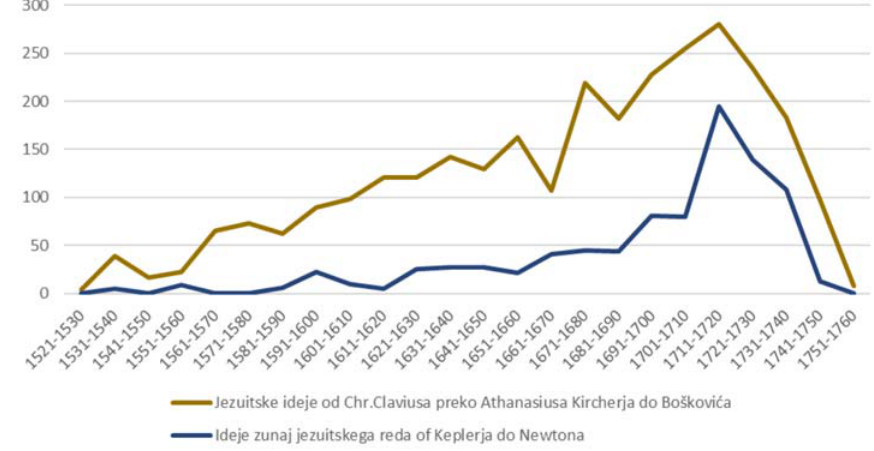
Graf 3: Spreminjanje fizikalnih idej poldrugih tiso~ jezuitskih profesorjev matematike-fizike iz avstrijske in ~e{ke province po dekadah rojstva. Po- membnost profesorjev je ocenjena od 1 do 9 glede na pisana dela, pomembne katedre, va`ne slu`be in plemi{ki